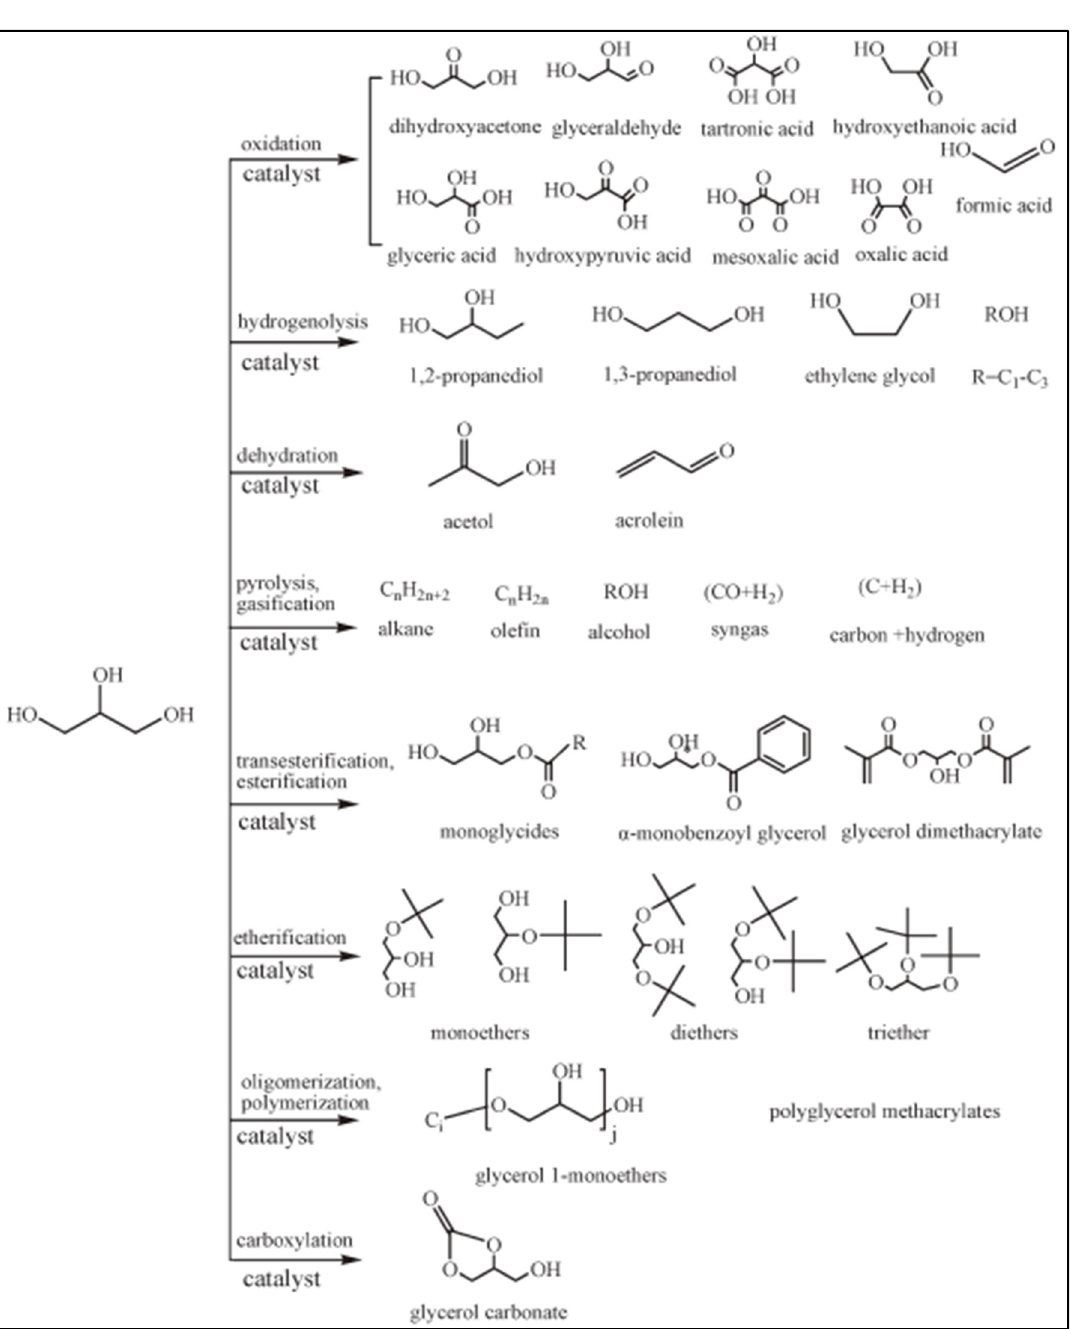
Figure 2. Potential products of conversion of glycerol. Reprinted/adapted with permission from Zhou, et al. [29], Royal Society of Chemistry, 2009.